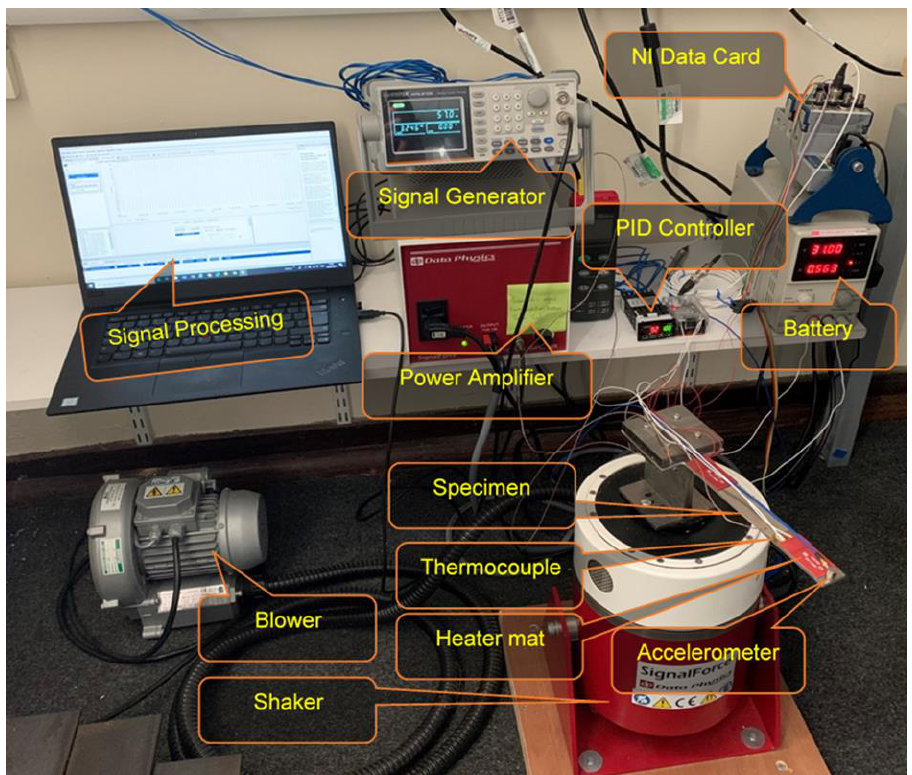
Figure 3. Detail of the experiments.